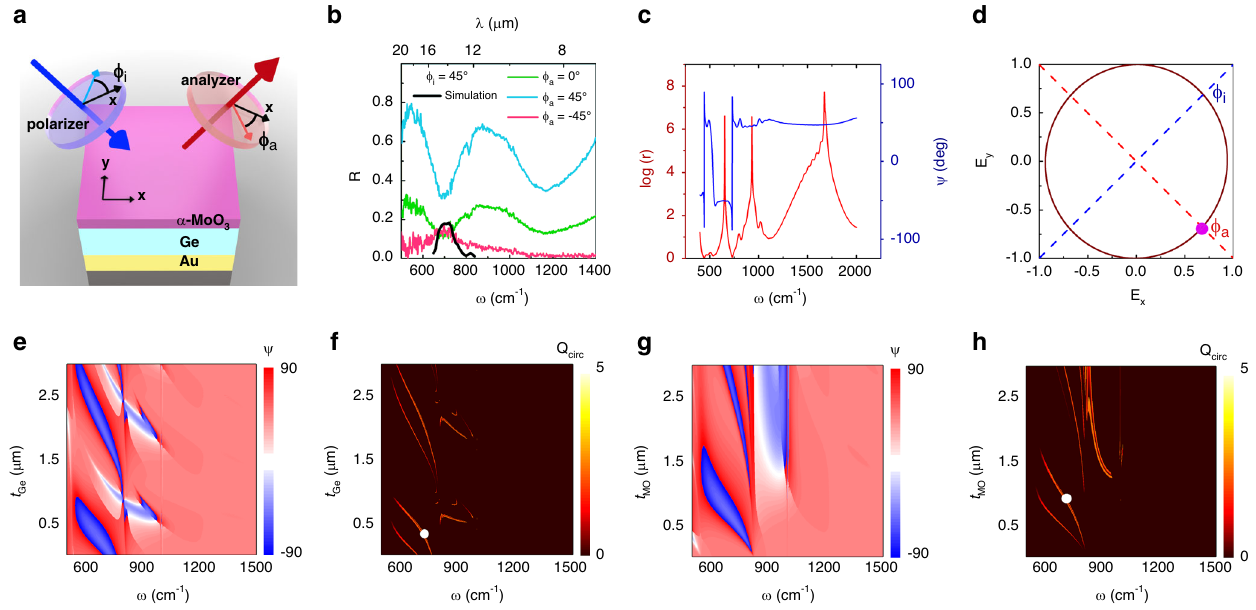
Fig. 5 RS band enhanced birefringence in α -MoO 3 . a Schematic of depolarization experiment, ( b ) re fl ectance of sample S2 for different analyzer values ϕ a when polarizer is set to ϕ i = 45°, the black curve is the simulated intensity for ϕ a = − 45°. c Simulated polarization ellipse characteristics, ellipticity ( r ) and polarization ellipse major axis angle ( ψ ). d Simulated polarization ellipse of re fl ected beam at ω = 727 cm − 1 which represents circularly polarized light. The purple dot represents an example of the | E | value from the re fl ected polarization ellipse at ω = 727 cm − 1 used for obtaining the black simulation curve in panel b . e Spectral polarization ellipse major axis angle ( ψ ) versus Ge thickness ( t Ge ) and ( f ) spectral quarter-wave plate action quality factor ( Q circ ) versus t α -MoO t = 0.95 μ m and incident angle θ = 25° and ϕ = 45°. g ψ versus t Q t t = 0.42 μ m and i MO and ( h ) Ge , with 3 thickness MO circ versus MO , with Ge θ = 25° and ϕ i = 45°. The white dots in panels f and h are the experiment data points representing the circularly polarized re fl ected beam in panel d